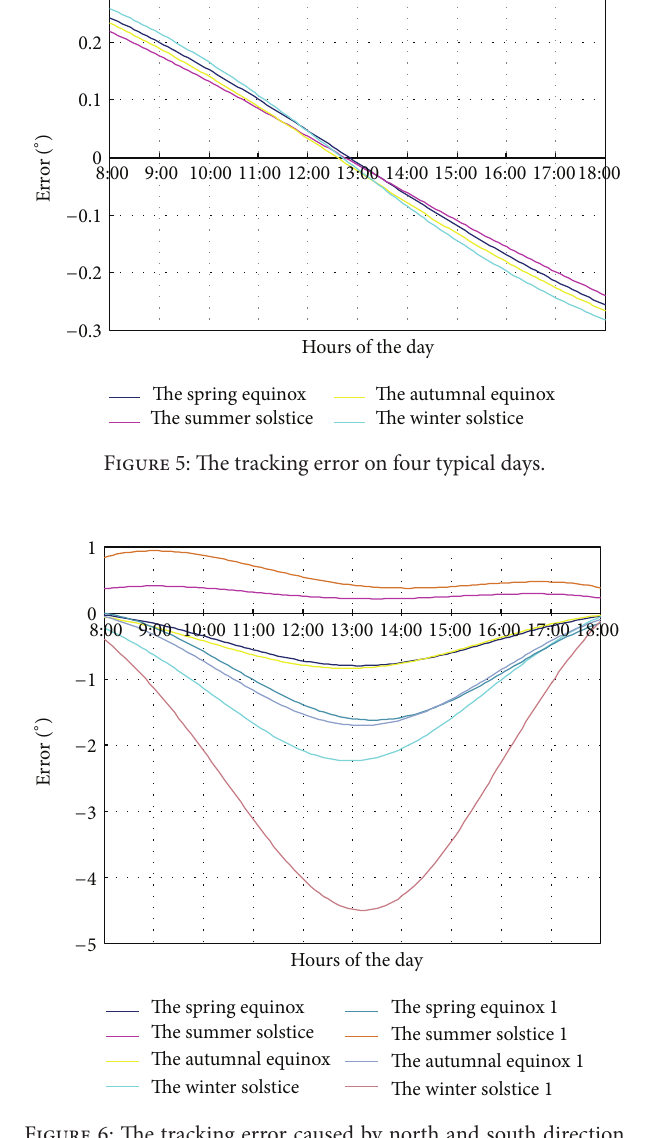
Figure 6: The tracking error caused by north and south direction negative deviation on four typical days.